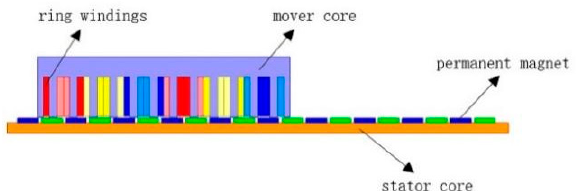
Figure 1. PMLSM Figure 1. PMLSM structure.